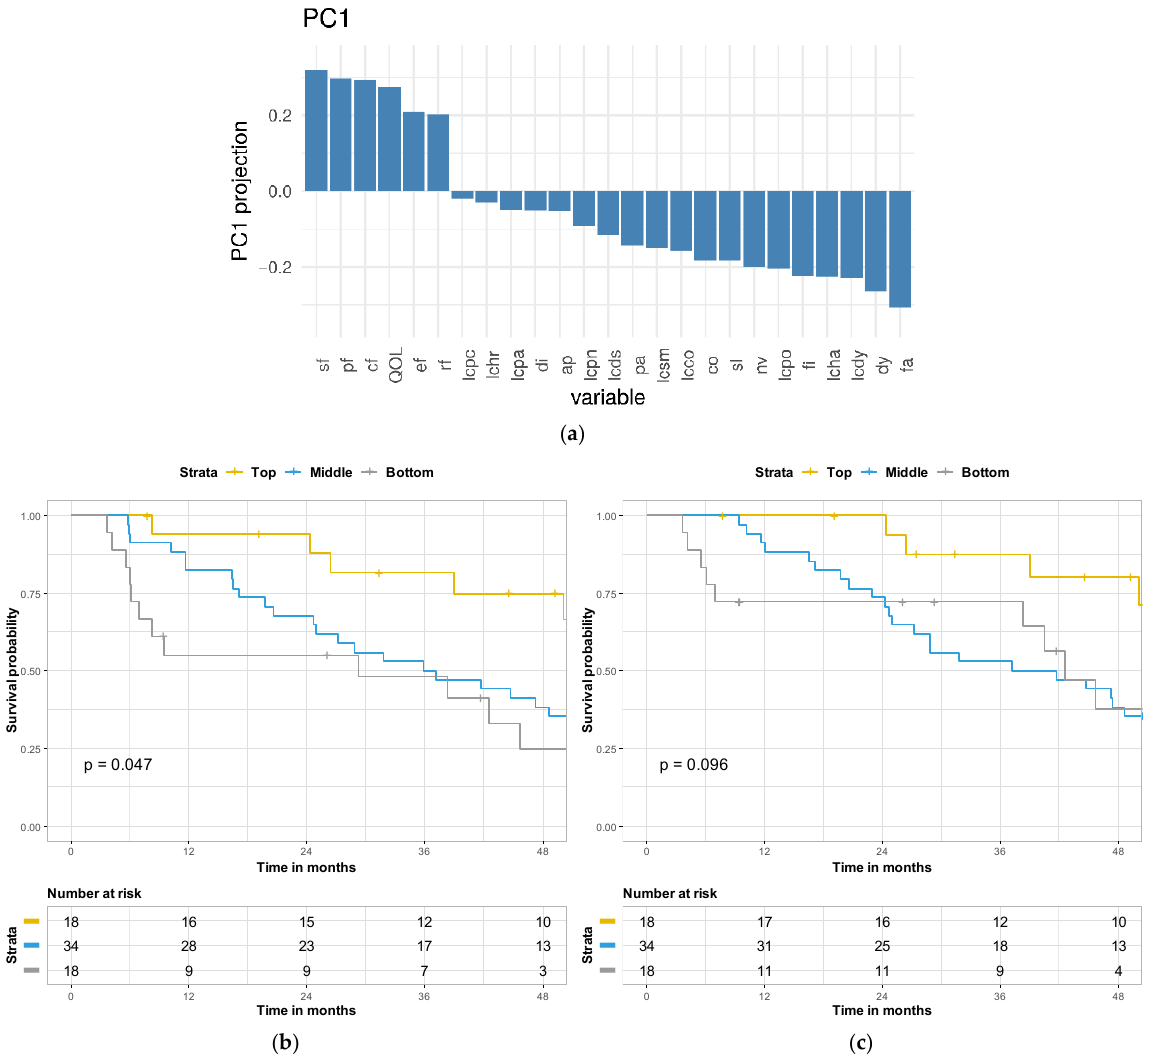
Figure 1. Principal component analysis of the change in health-related quality-of-life (HRQOL) metrics and outcome. ( a ) Waterfall plot demonstrating the weighted contribution of each HRQOL scale. ( b ) Kaplan–Meier analysis of progression-free survival and PC1 quartile. ( c ) Kaplan–Meier analysis of overall survival and PC1 quartile. Definition of HRQOL scales as follows: social functioning (SF); physical functioning (PF); cognitive functioning (CF); global health status (QOL); emotional functioning (EF); role functioning (RF); pain in chest (LCPC); alopecia (LCHR); pain in arm/shoulder (LCPA); diarrhea (DI); appetite (AP); peripheral neuropathy (LCPN); dysphagia (LCDS); pain (PA); sore mouth (LCSM); constipation (CO); insomnia (SL); nausea/vomiting (NV); pain in other parts (LCPO); financial difficulties (FI); hemoptysis (LCHA); dyspnea (LCDY); dyspnea (DY); fatigue (FA).